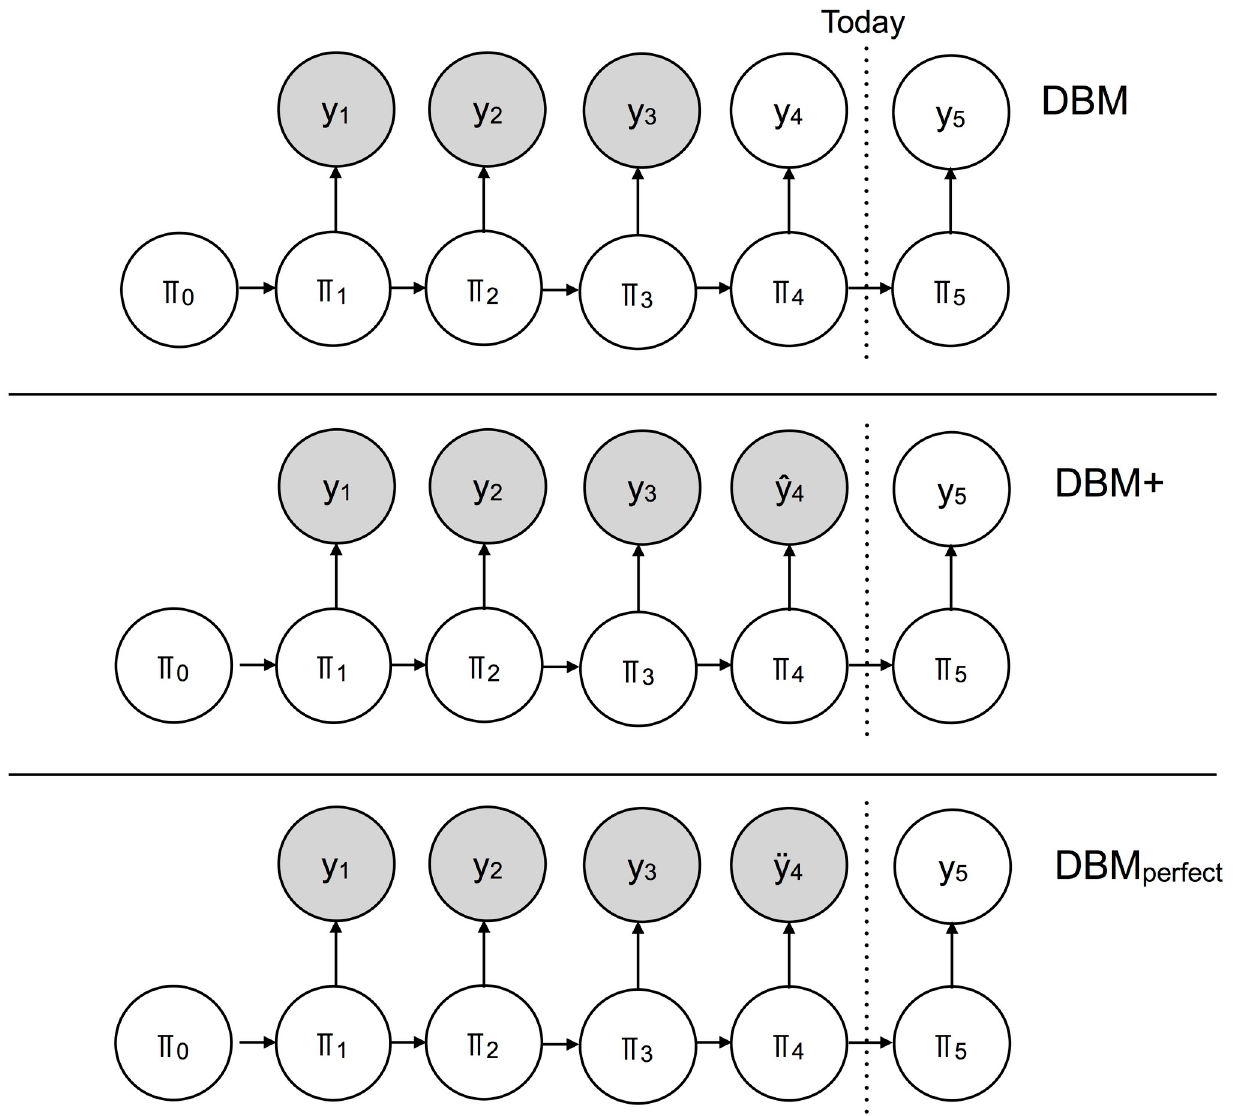
Fig 6. The simplified graphical representations of DBM, DBM+, and DBMperfect. π t is the latent state of ILI for week t , while y t is available ILI. Observed nodes are shaded; unobserved nodes are unshaded. The ILI reporting lag creates a gap between the day a forecast is rendered (vertical “Today” line) and the most recent available ILI estimate ( y 3 ). DBM does not fill in the reporting gap, denoted by the unshaded node y 4 . DBM+ fills in the reporting gap with a nowcast, denoted by the shaded node ŷ 4 . DBMperfect cheats by filling the reporting gap with the actual validation ILI, denoted by the shaded node ÿ 4